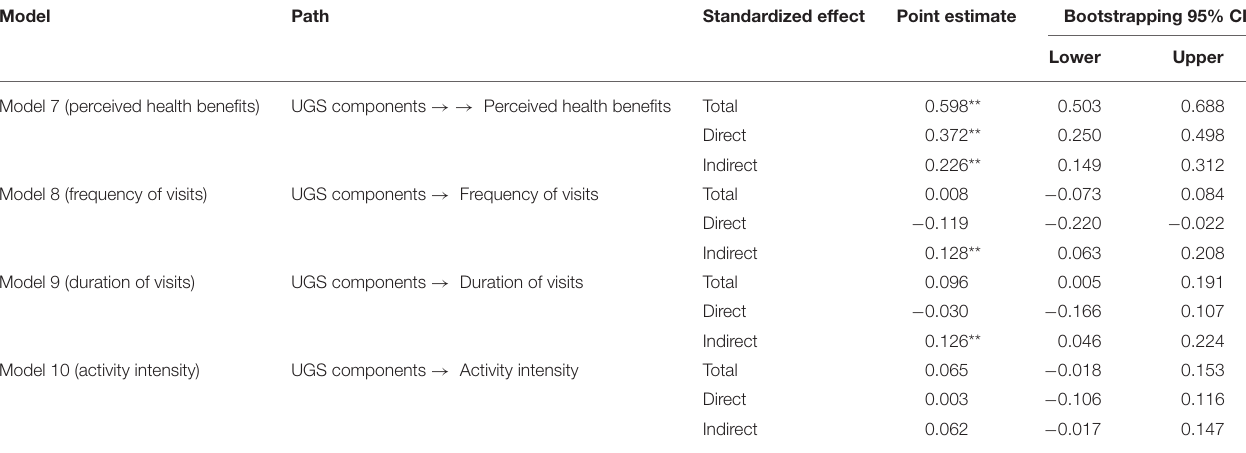
TABLE 8 | Model effect